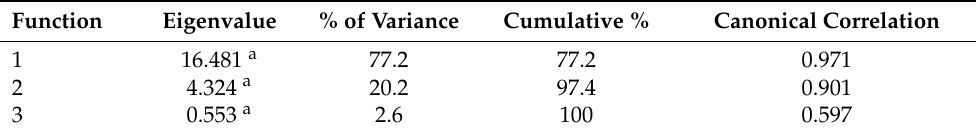
Table 8. Eigenvalues for the discriminant analysis.